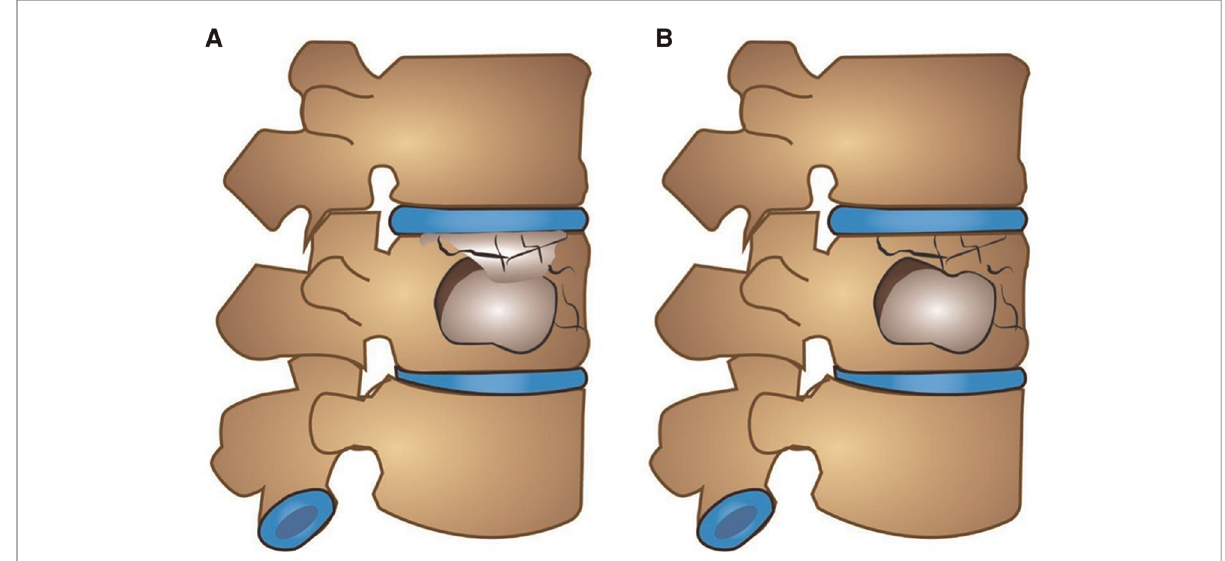
FIGURE 1 Schematic diagram of both groups. ( A ) The bone cement was not only distributed in the fractured vertebral body, but also diffused into the cracks of the endplate. ( B ) The bone cement was only con fi ned in the fractured vertebral body but did not diffuse into the endplate